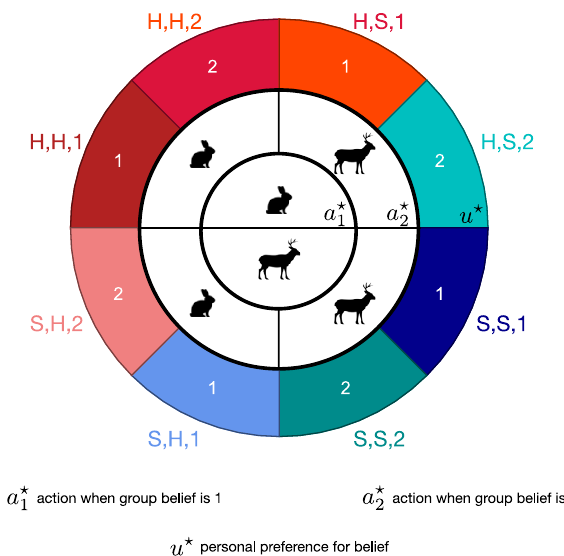
Fig. 1 The types of individuals in the world. Individuals are aware of the existence of narratives 1 and 2. They have a personal belief in either 1 or 2. The actions of the individuals could be H or S (shown as icons). Thus, the strategy of a focal individual ( ⋆ ) is de fi ned by ð a ? hunting strategy of the focal individual when the group chooses to collectively believe in narrative i and u ⋆ is the narrative that the individual personally believes in. Following their own narratives, the red-tinged strategies would hunt hares, and blue-tinged,